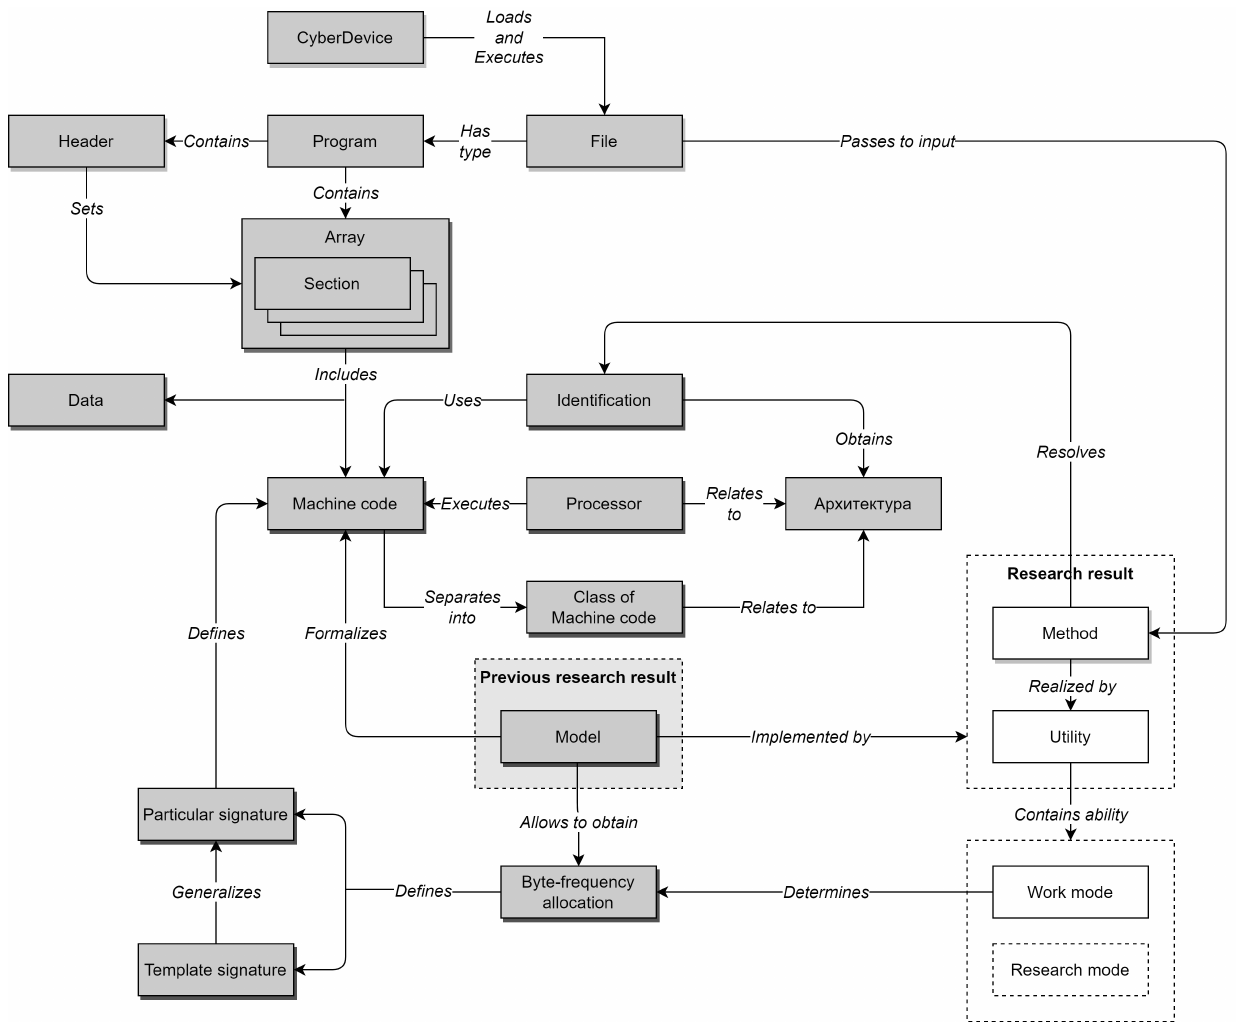
Figure 2. Representation of the domain ontological